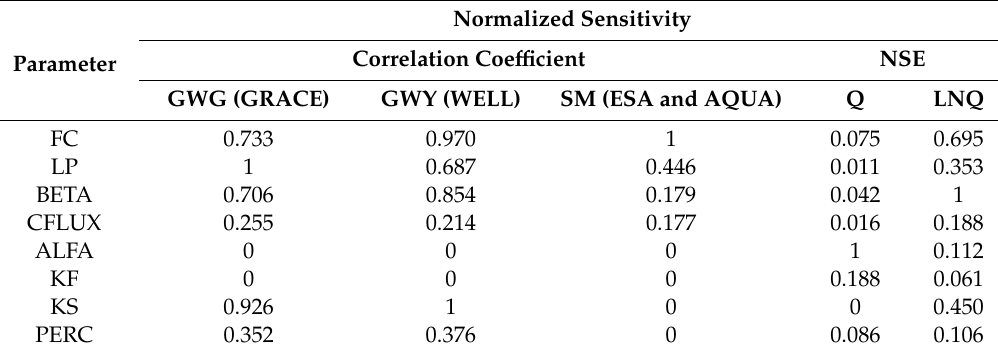
Table 5. Normalized (from 0 to 1) sensitivity indices of eight HBV